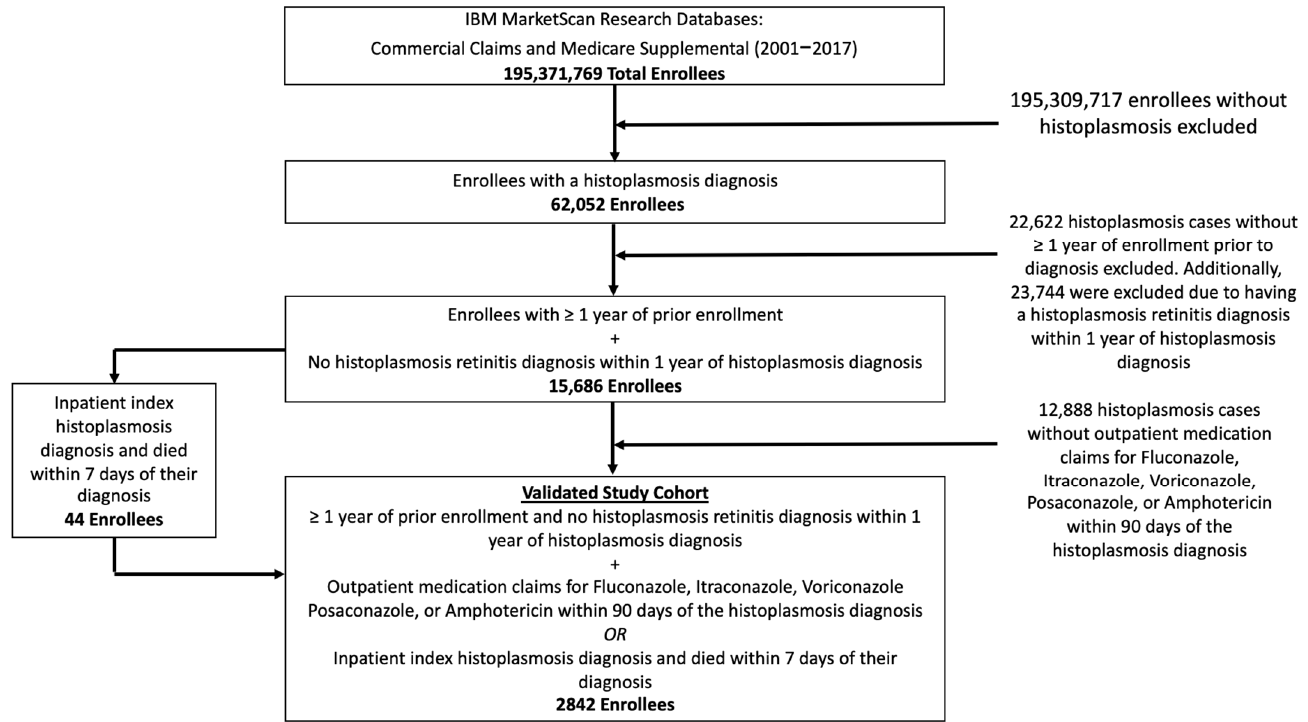
Figure 2. Inclusion and exclusion criteria and counts of included and excluded patients.